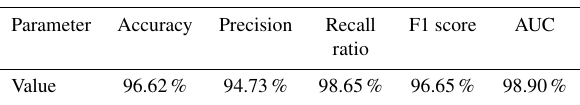
Table 3. Prediction performance of the TG-1 model during testing